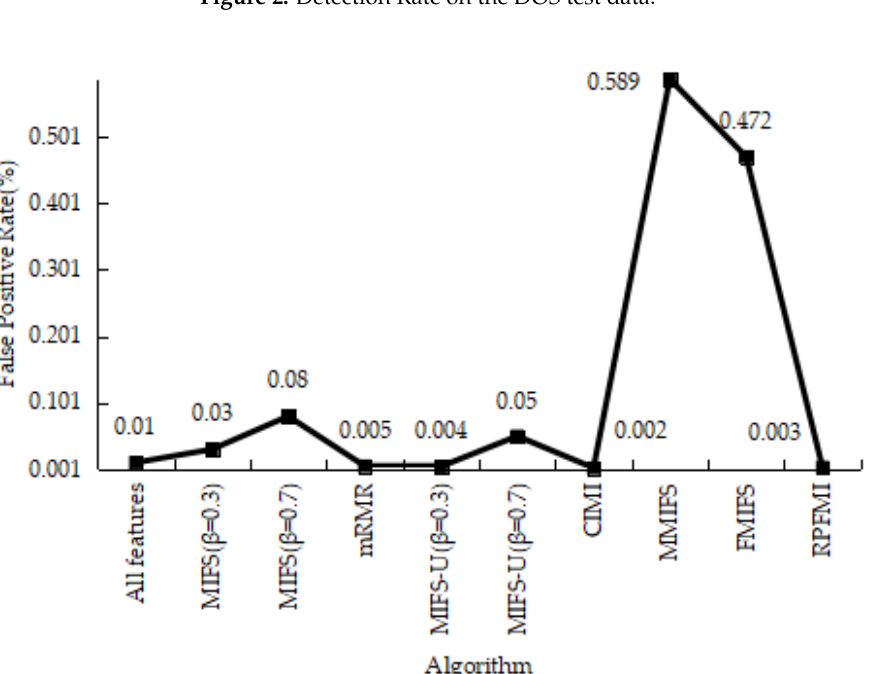
Figure 2. Detection Rate on the DOS test data.